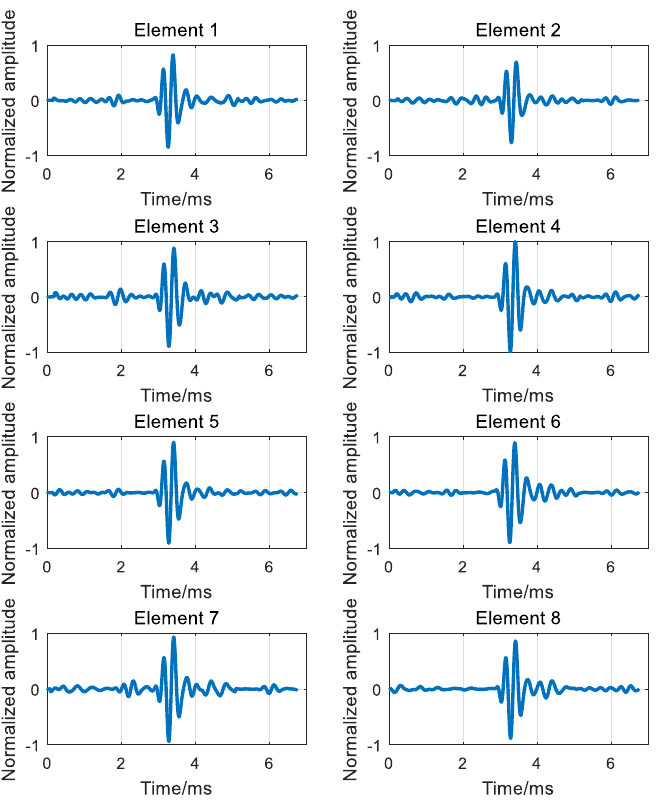
Figure 13. The second received signals of element 1 – 8.